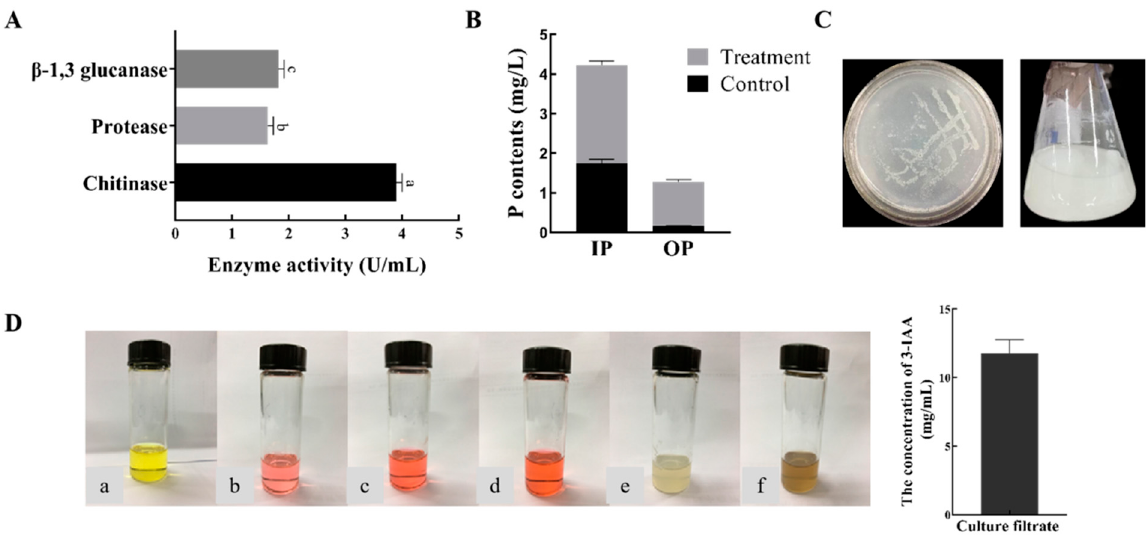
Figure 7. Extracellular enzyme activities and assays for detection of PGP abilities. ( A ), Extracellular enzyme activities ( β -1,3 glucanase, protease, chitinase); Different lower-case letters on the bars indicate the significant difference at the p < 0.05 level using Duncan’s multiple range test. ( B ), Solubilize phosphate (Inorganic phosphorous (IP); Organic phosphorus (OP)); ( C ), Nitrogen-fixation plate and shake flask test; ( D ), IAA production and content (Colorimetric analysis was conducted on compounds derived from Indole-3-Acetic Acid (IAA). (( a ), colorimetric solution + sterile water; ( b ), colorimetric solution + 10 mg/L IAA; ( c ), colorimetric solution + 30 mg/L IAA; ( d ), colorimetric solution + 50 mg/L IAA; ( e ), colorimetric solution + LB borth; ( f ), colorimetric solution + sterile filtrate).